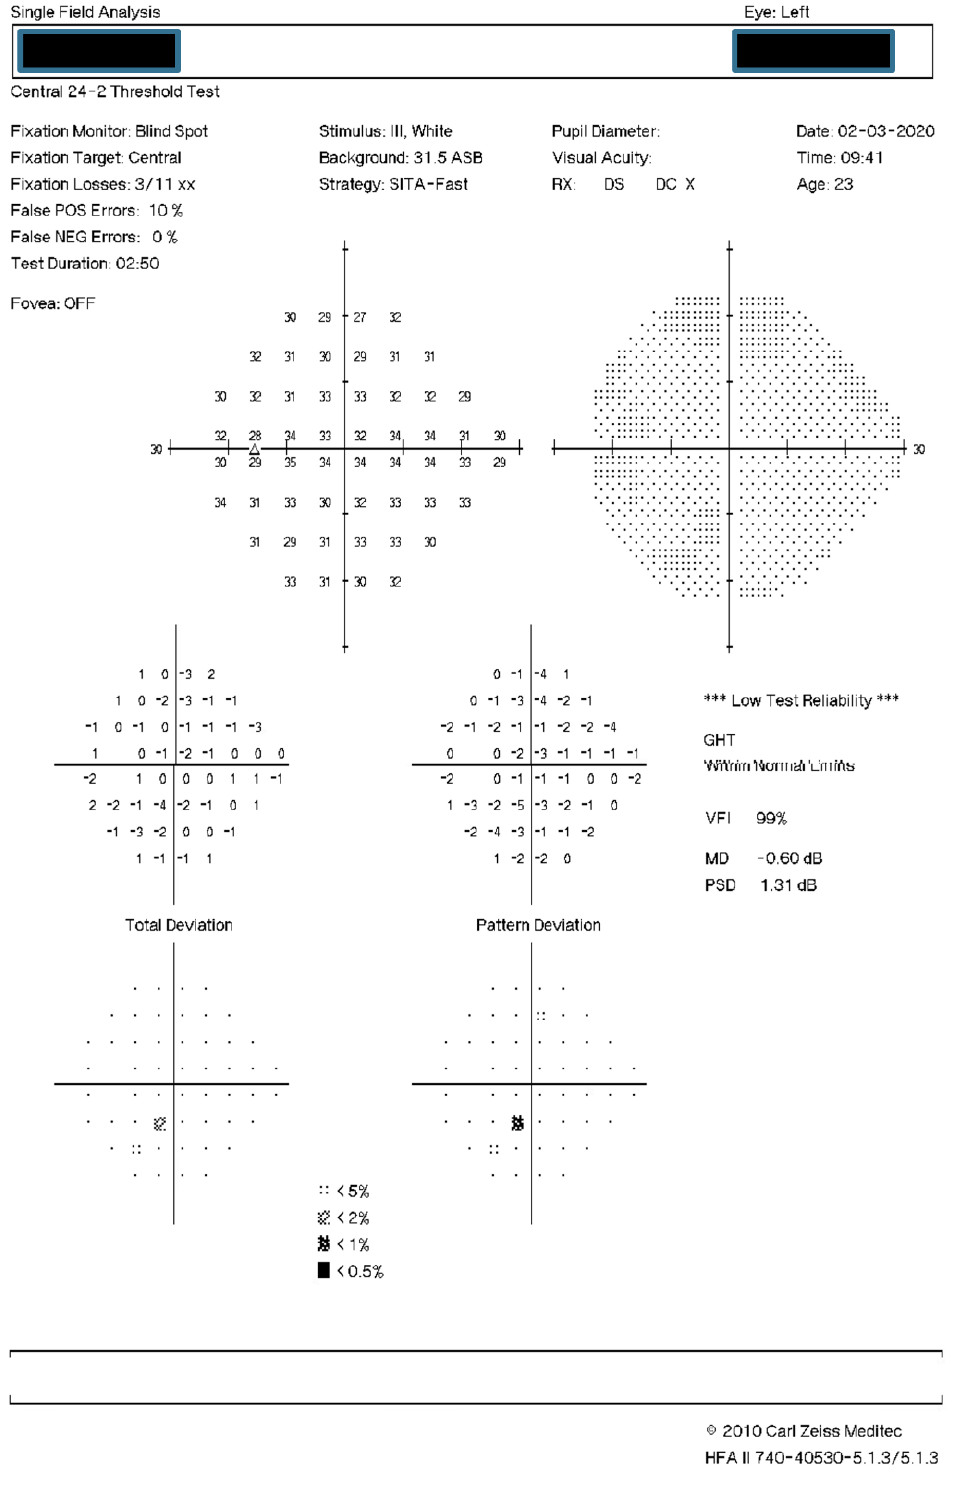
Figure 2. Visual field analysis March 2020. 24-2 Humphrey Visual Field of the right and left eyes taken one week after initial presentation showing no significant perimetry defects.